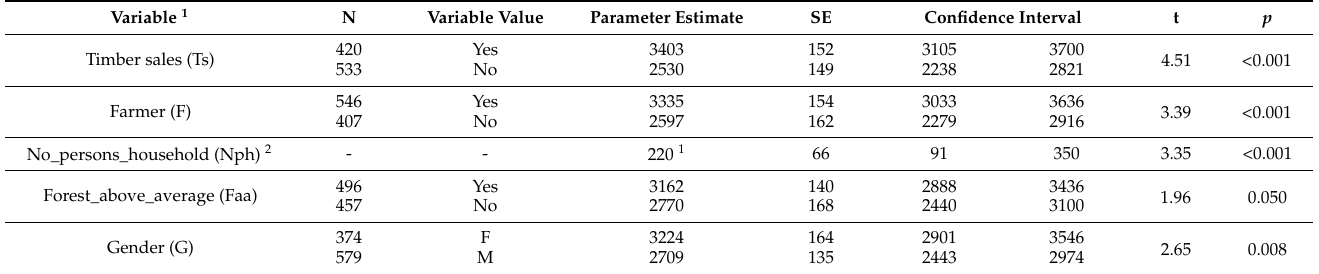
Table 5. Results of multiple regression analysis of response variable WTA2 on explanatory variables (variable values: 1, yes; 0, no; parameter estimate: expected value of WTA2) in research conducted in April 2019 on a random representative nationwide sample of forest owners (farmers). SE, standard